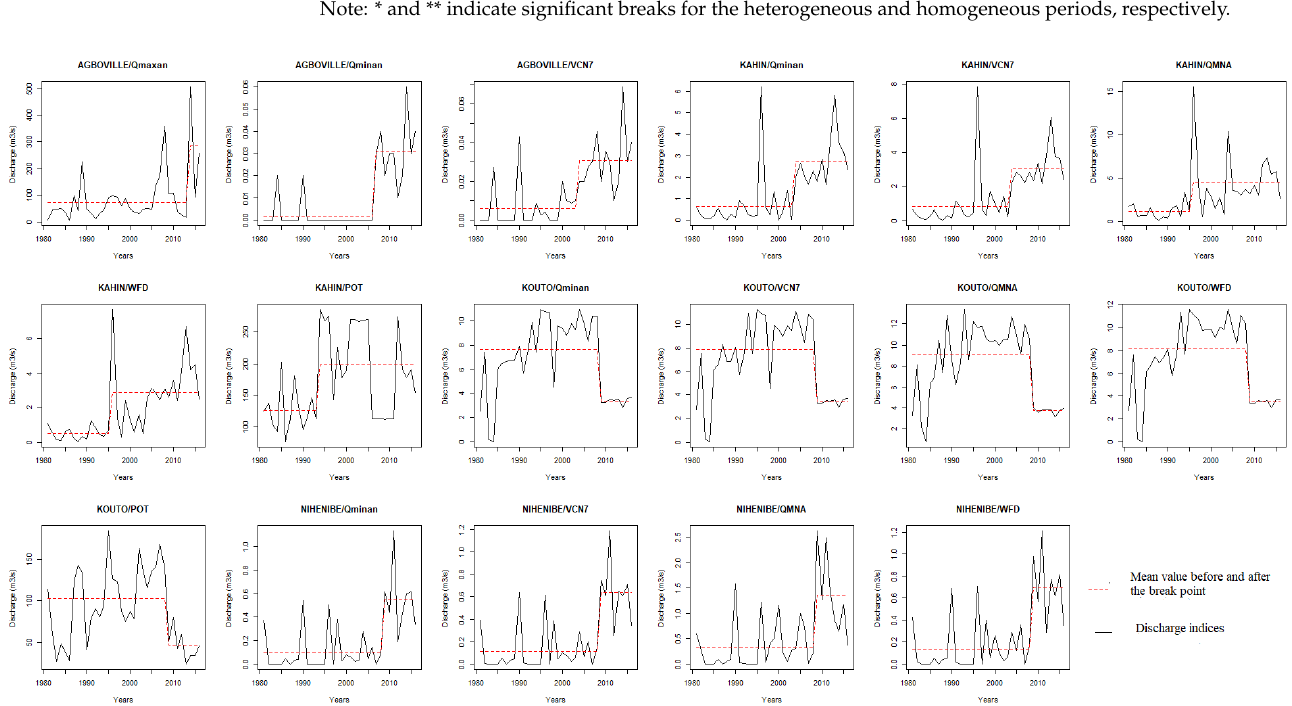
Table 6. Break point detection related to the heterogeneous and homogeneous periods for flood indices and low-discharge indices in the selected river watersheds in Côte d’Ivoire for the period 1981–2016.